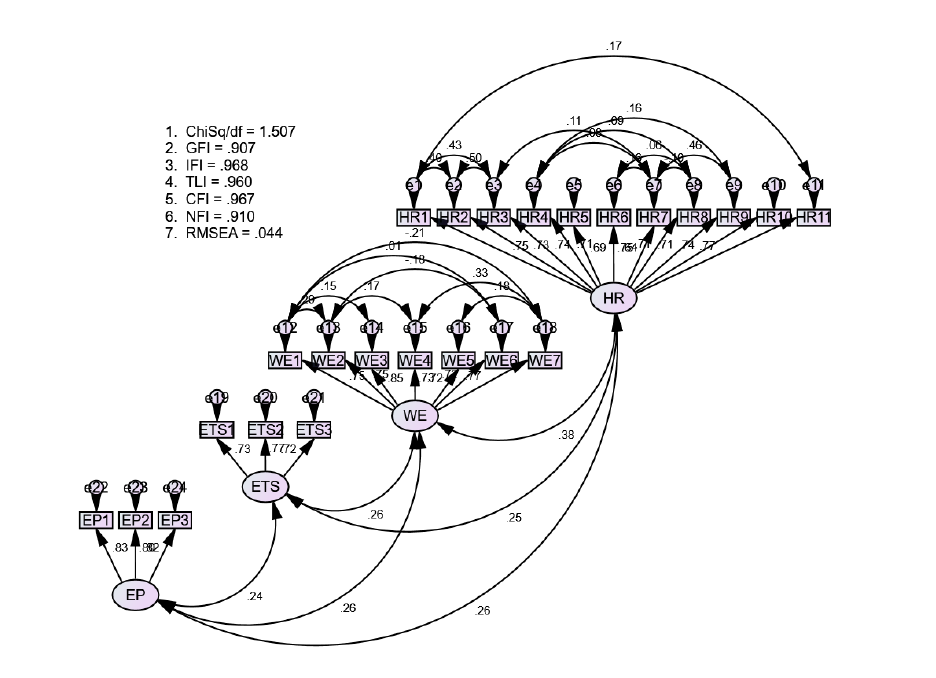
Figure 2: Confirmatory Factor